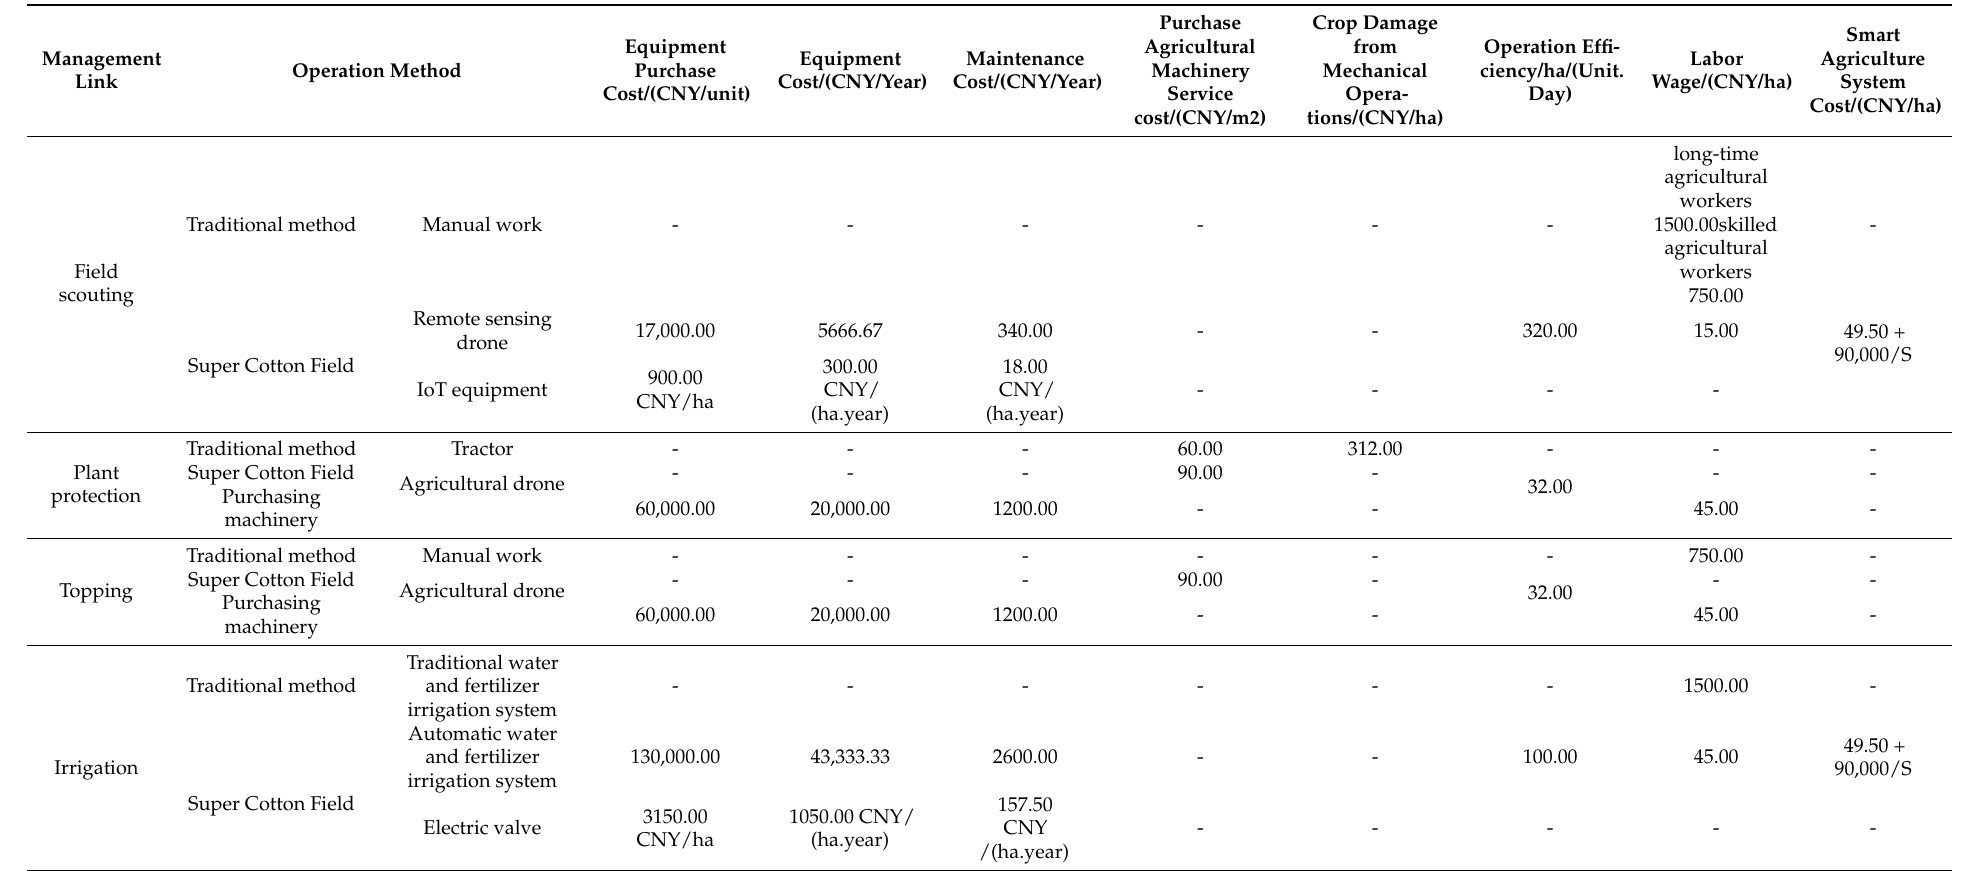
Table 2. Operational cost parameters for cotton field